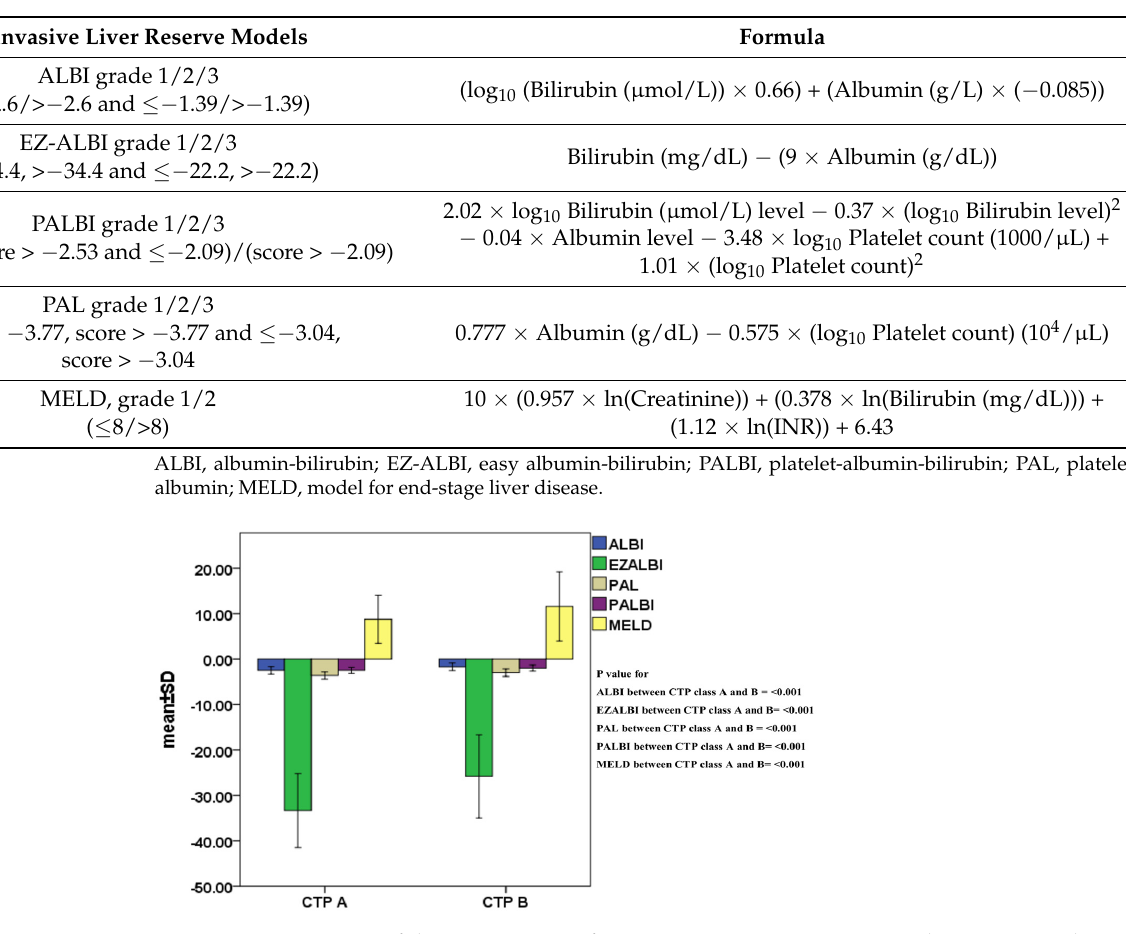
Table 2. Formula and grading of noninvasive liver reserve